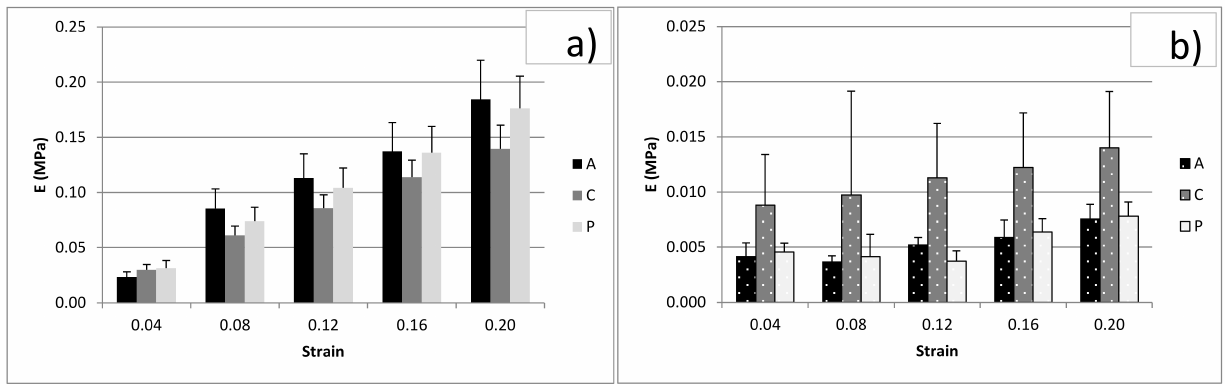
Figure 7. Compression tests: Moduli for different strain levels, from 0.04 to 0.20, and for different regions: anterior (A), central (C), posterior (P). ( a ) Values for FD menisci and ( b ) values for PD menisci. Bars are standard errors.